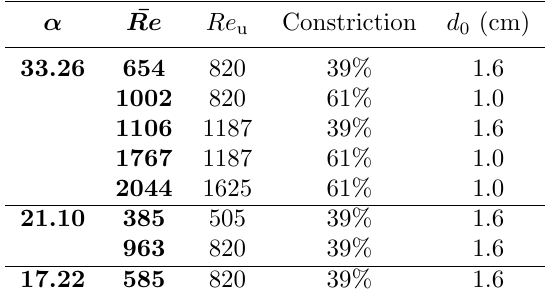
Table 1: Experimental degrees of constriction and ¯ Re numbers.